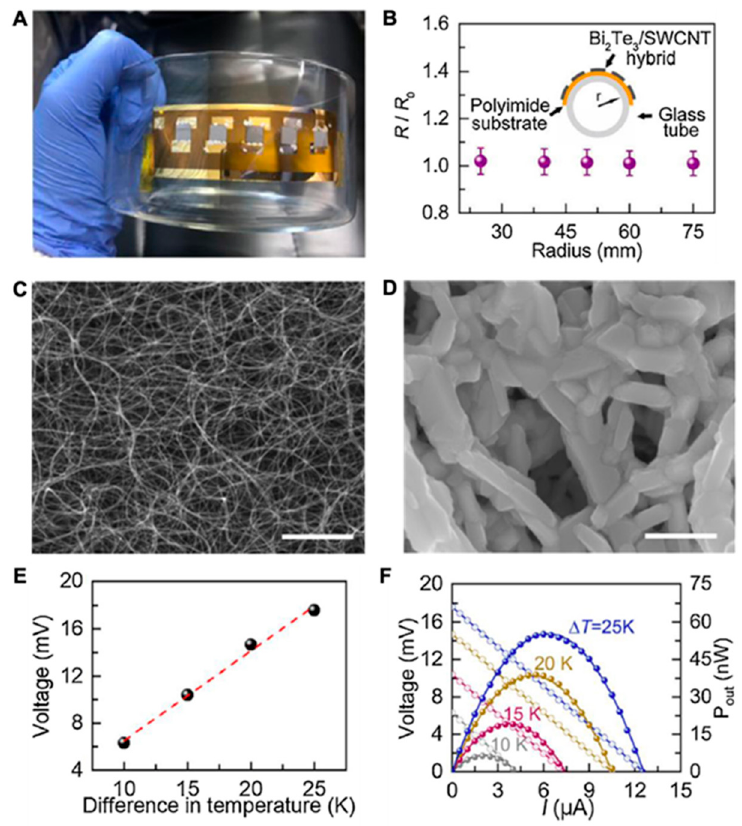
Figure 8. A flexible thermoelectric device based on hybrid Bi 2 Te 3 –SWCNTs. ( A ) The camera image of the WTEG device; ( B ) the bending performance of WTEG at different tube radii; ( C ) SEM image of SWCNTs; ( D ) SEM image of Bi 2 Te 3 –SWCNTs hybrid; ( E ) the output voltage of the hybrid Bi 2 Te 3 – SWCNTs at different ∆ T; ( F ) the corresponding thermoelectric performance of the hybrid Bi 2 Te 3 – SWCNT-based WTEG, reprinted from [22], copyright (2020), Li, Y.; Qiao, J.; Zhao, Y.; Lan, Q.; Mao, P.; Qiu, J.; Tai, K.; Liu, C.; Cheng, H. with permission from Elsevier.